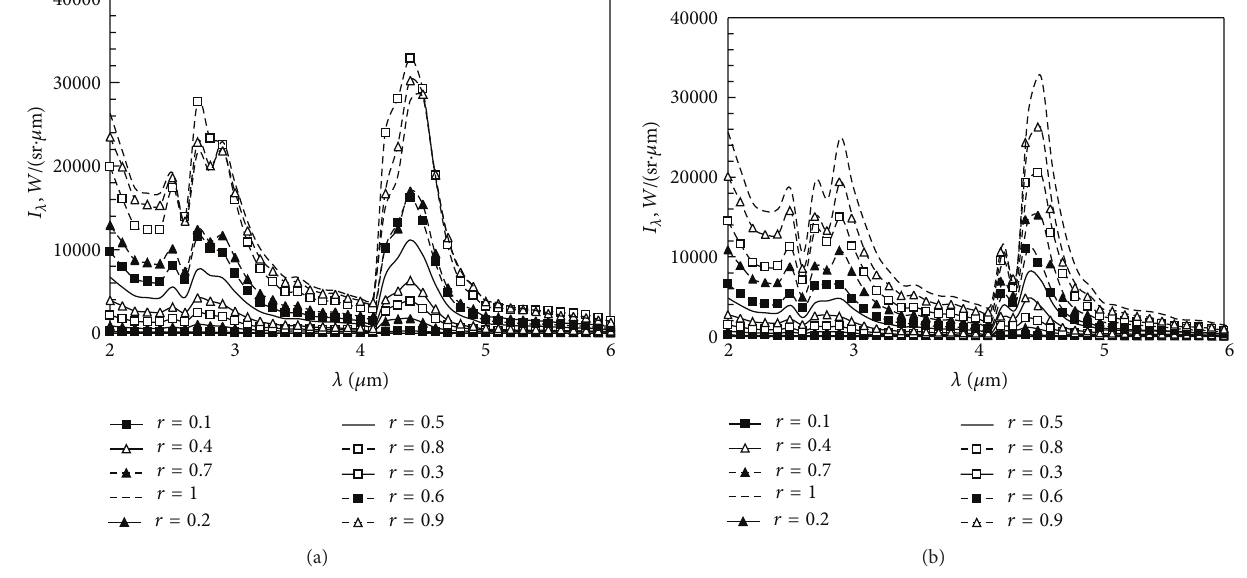
Figure 10: Spectral radiation intensity of plume surface.